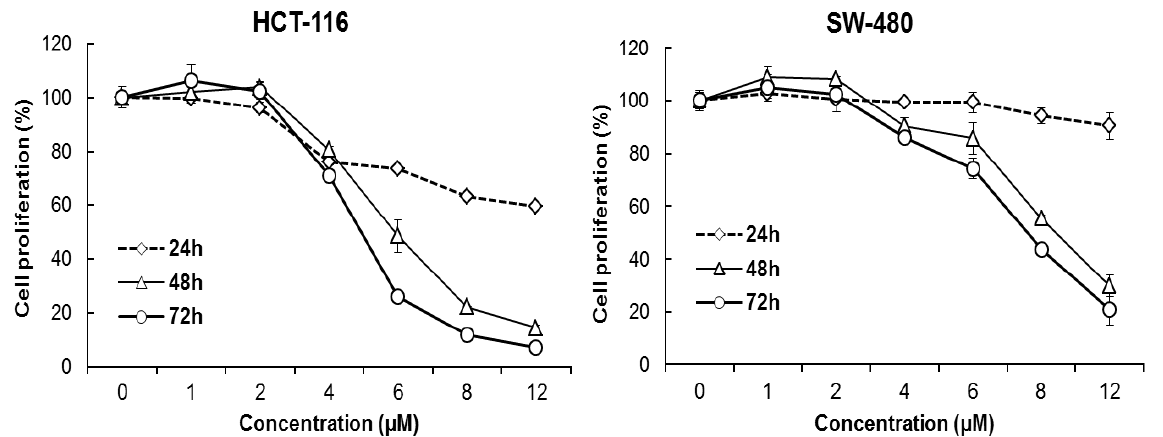
Figure 3. Oplopantriol A (OPT A) inhibits human HCT-116 and SW-480 colorectal cancer cell proliferation. Cell survival is determined by MTS assay and calculated as a ratio of the control. OPT A significantly inhibits HCT-116 and SW-480 cell proliferation in a time- and concentration-dependent manner (both p < 0.01). HCT-116 cells show more sensitivity than SW-480 cells to OPT A treatment at the indicated concentrations. Data are presented of triplicate wells and three independent experiments.